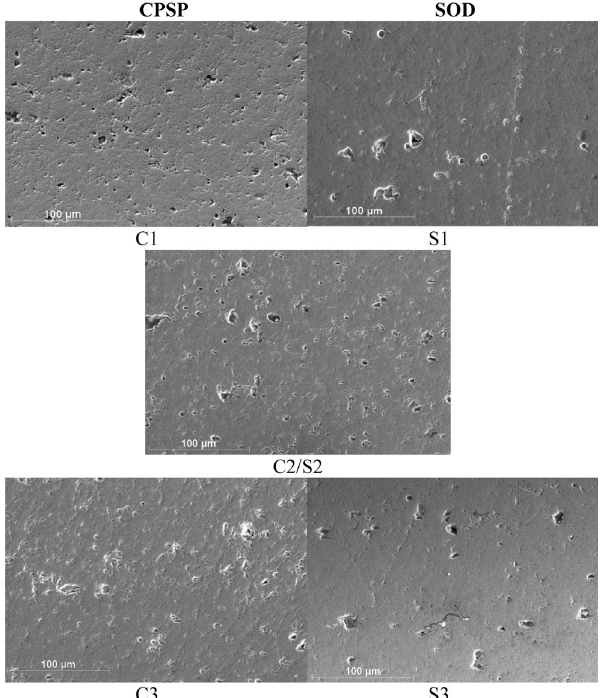
Fig. 3 SEM images of cross section of chromia coating at 1000x for listed parametric variations.